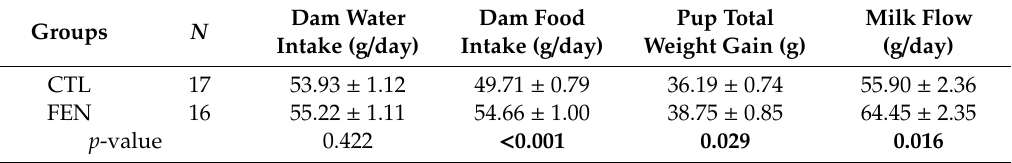
Table 1. E ff ect of fenugreek supplementation on dams’ lactation performances. Groups